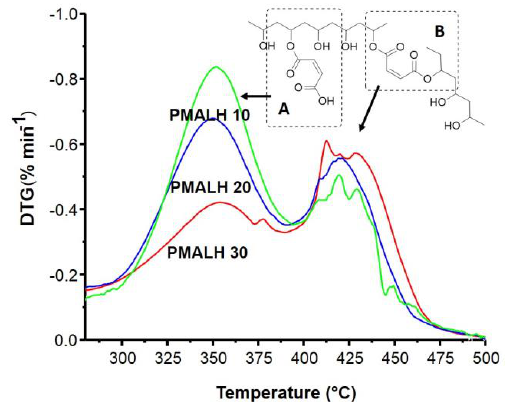
Figure 5. DTG between 280 and 500 °C and possible crosslinking. ( A ) fraction PVA-AM and ( B ) fraction PVA-AM-PVA.